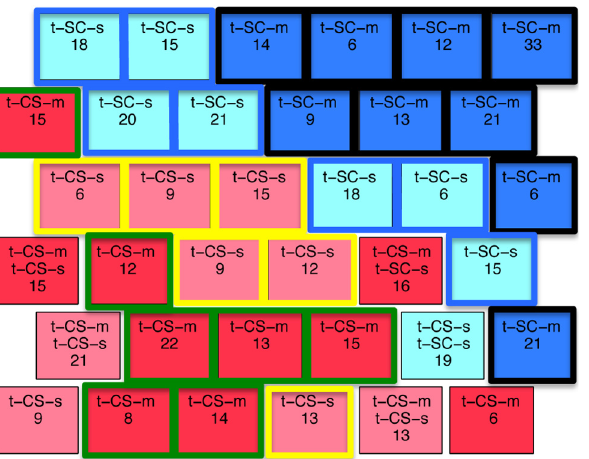
Fig 6. SOM clustering of trisomic mice data using 77 proteins. Light blue: t-SC-s; dark blue: t-SC-m; light pink: t-CS-s; dark pink: t-CS-m. Nodes forming each cluster are outlined: blue: t-SC-s; black: t-SC-m; yellow: t-CS-s; green: